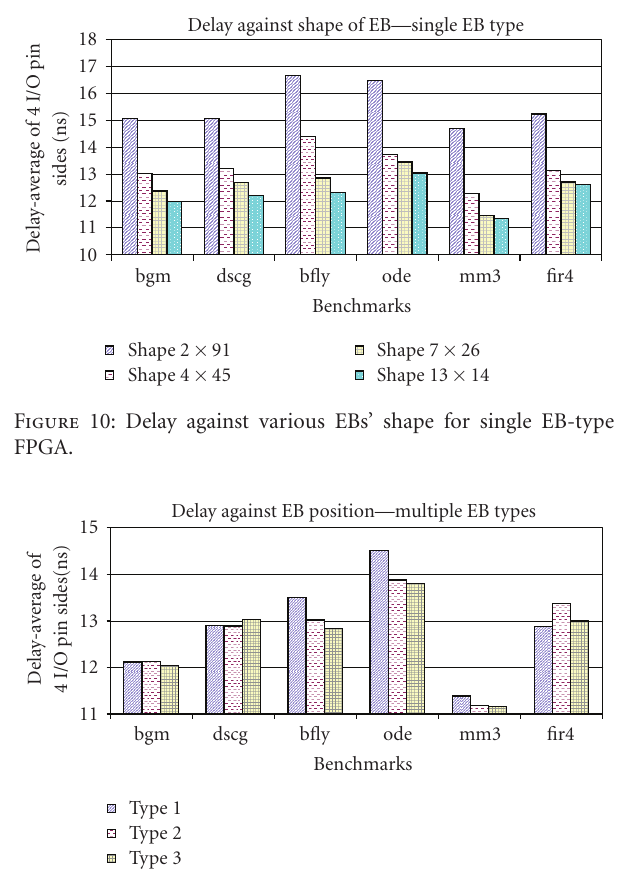
Figure 11: Delay against various EBs positions for multiple EB types FPGA, as defined in Figure 6.